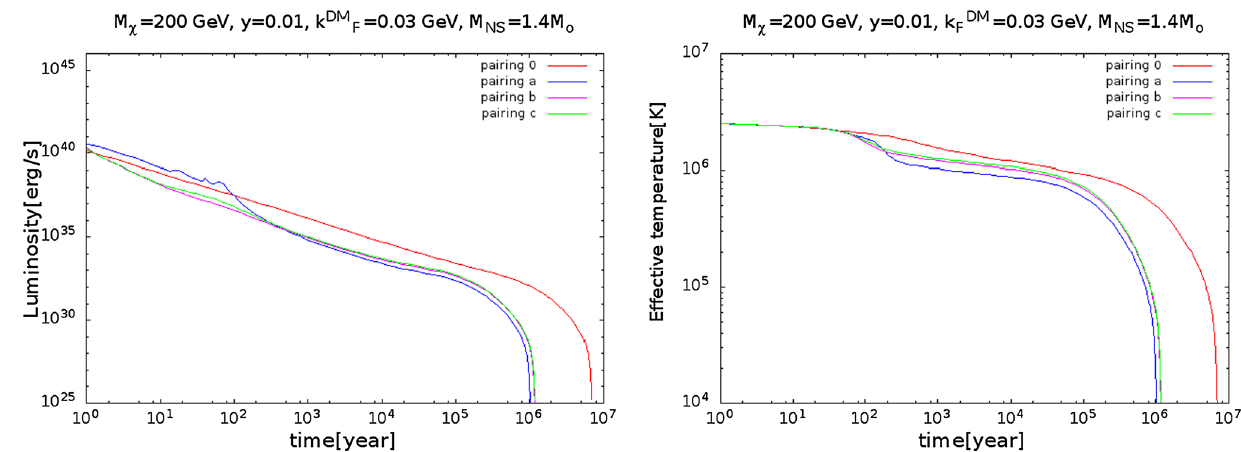
Fig. 15 Left panel is for luminosity vs time and right panel is for effective temperature vs time with different pairing gap models keeping M χ and k DM fixed in both the F